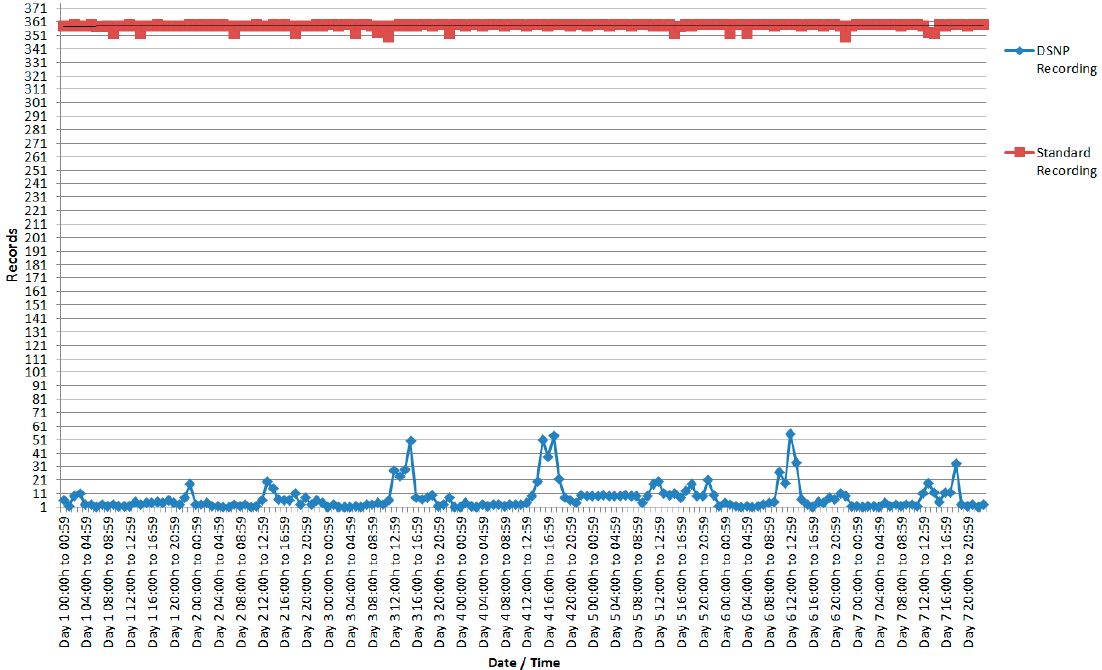
Figure 8. Number of records sent per each luminosity sensor.